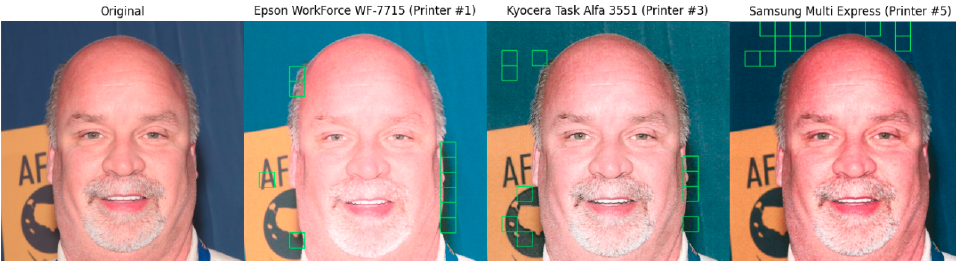
Figure 3. Image 139.jpg of the dataset (first column) and the top 10 energy blocks of size 128 × 128 for different versions of the image printed by various printers (remaining